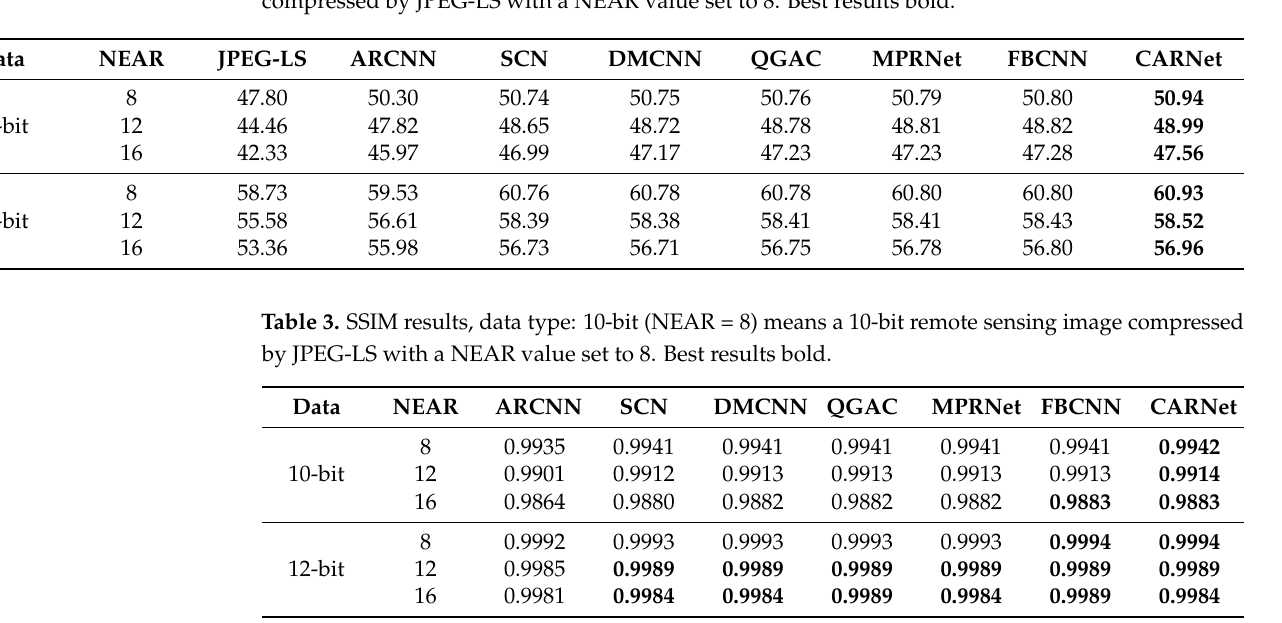
Table 2. PSNR (dB) results, data type: 10-bit (NEAR = 8) means a 10-bit remote sensing image compressed by JPEG-LS with a NEAR value set to 8. Best results bold.